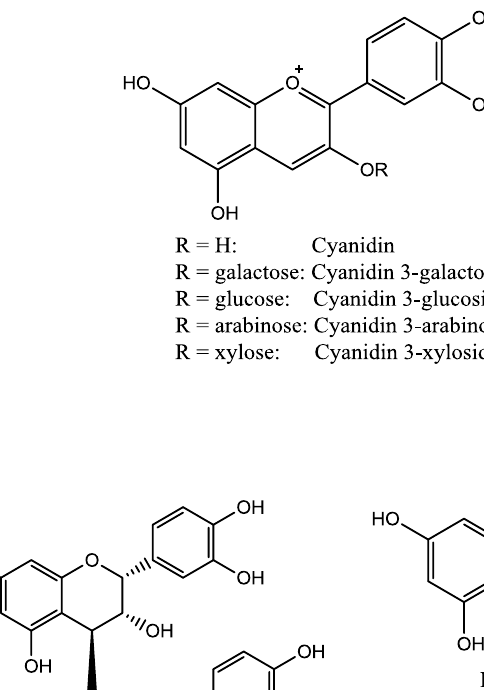
Figure 1. Chemical structures of compounds found in aronia berries.